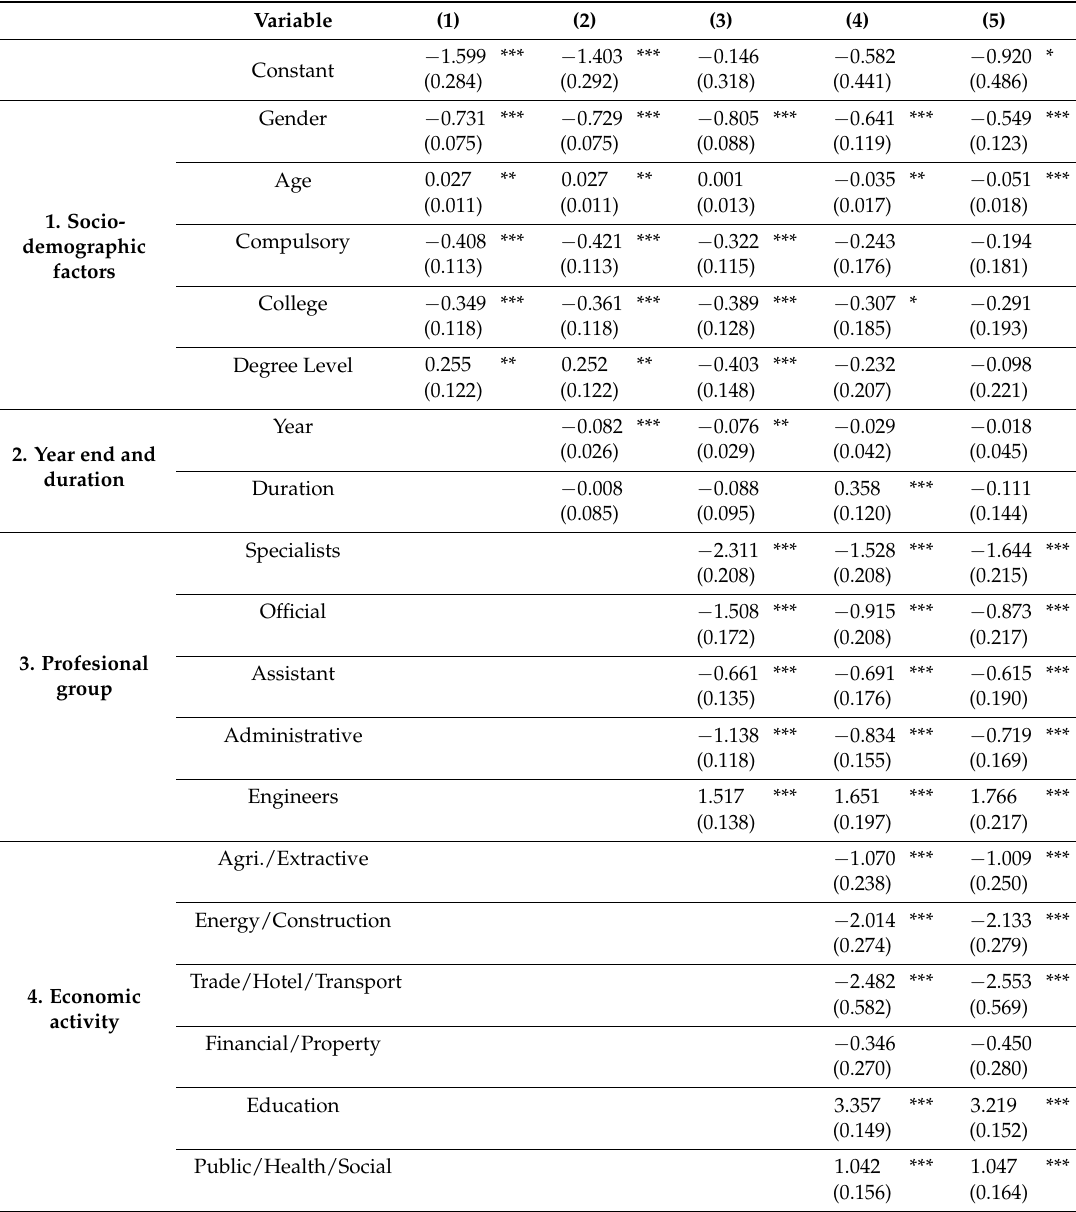
Table 4. Logit model